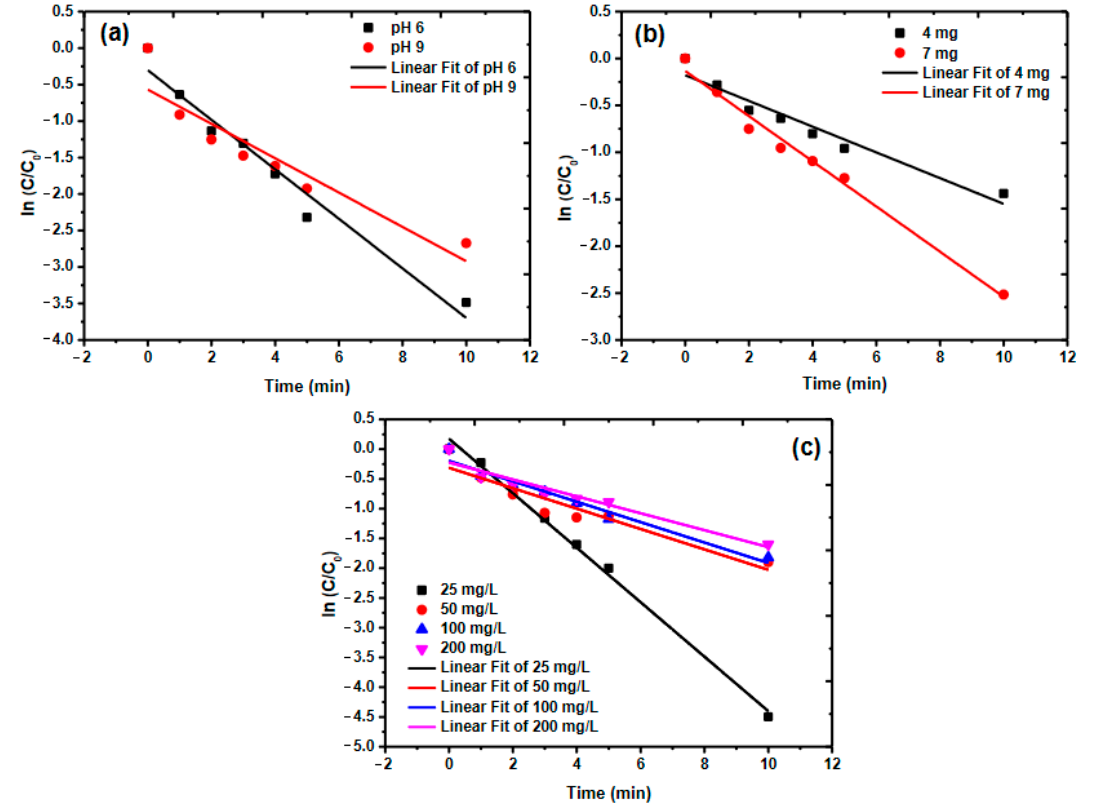
Figure 10. Pseudo first-order kinetics of MO degradation using Fe/Cu/Ag 5:1:0.2 nanoparticles varying the ( a ) pH, ( b ) nanoparticle dosage and ( c ) Initial MO